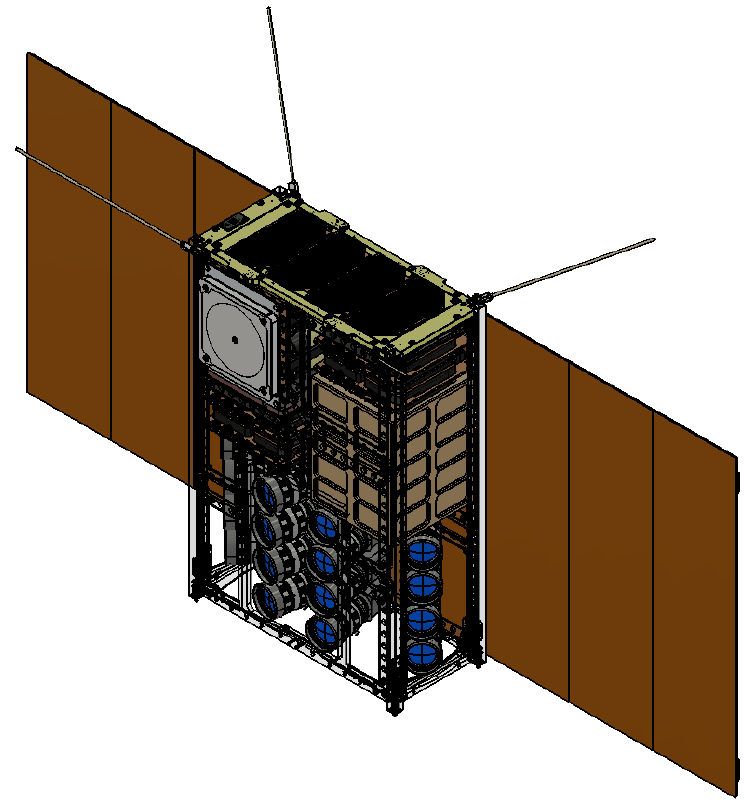
Figure 6. HORUS CAD model.